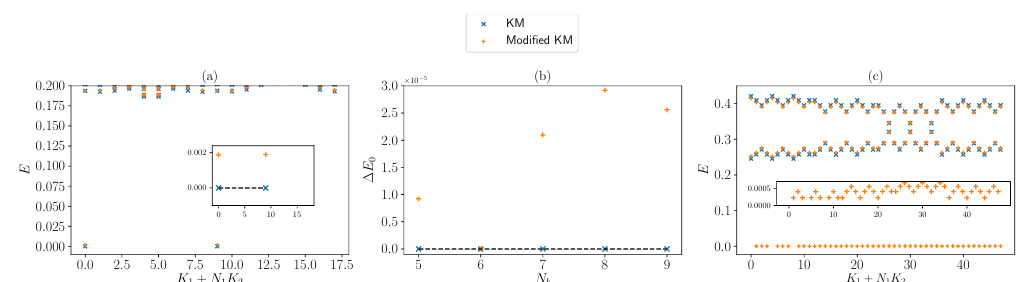
Figure 4: (a) The many-body spectrum at half filling for a 3-band ( φ = 1 / 3) KM model and its modified version with the constant Berry curvature for a lattice of × N /φ = 9 × 8 sites. The inset shows the two-fold degenerate ground states. The N 1 2 dashed horizontal line is the zero energy line. (b) The two-fold ground state degen- × 2 /φ eracy splitting ∆ E at half filling for different systems of N bosons in a N b b 0 lattice. The dashed horizontal line is the zero ground state splitting line. When the = 6), the modified model has the same ground state lattice is perfectly square ( N b energies as the original model hence the same ground state splitting. (c) The two- × N = 12 × 4 magnetic unit cells. The inset shows body spectrum for a system of N 1 2 the lowest non-zero two-body energy per total momentum sector for the modified KM model.